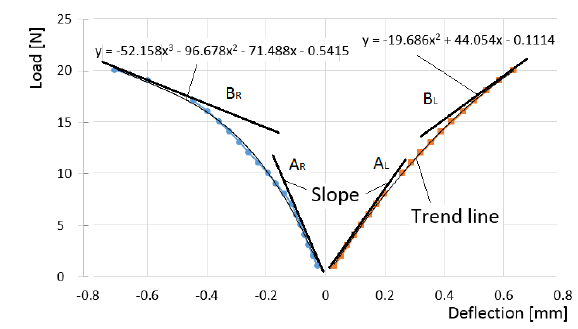
Figure 4: The degree of change in stiffness non-linearity. Source: Own study.